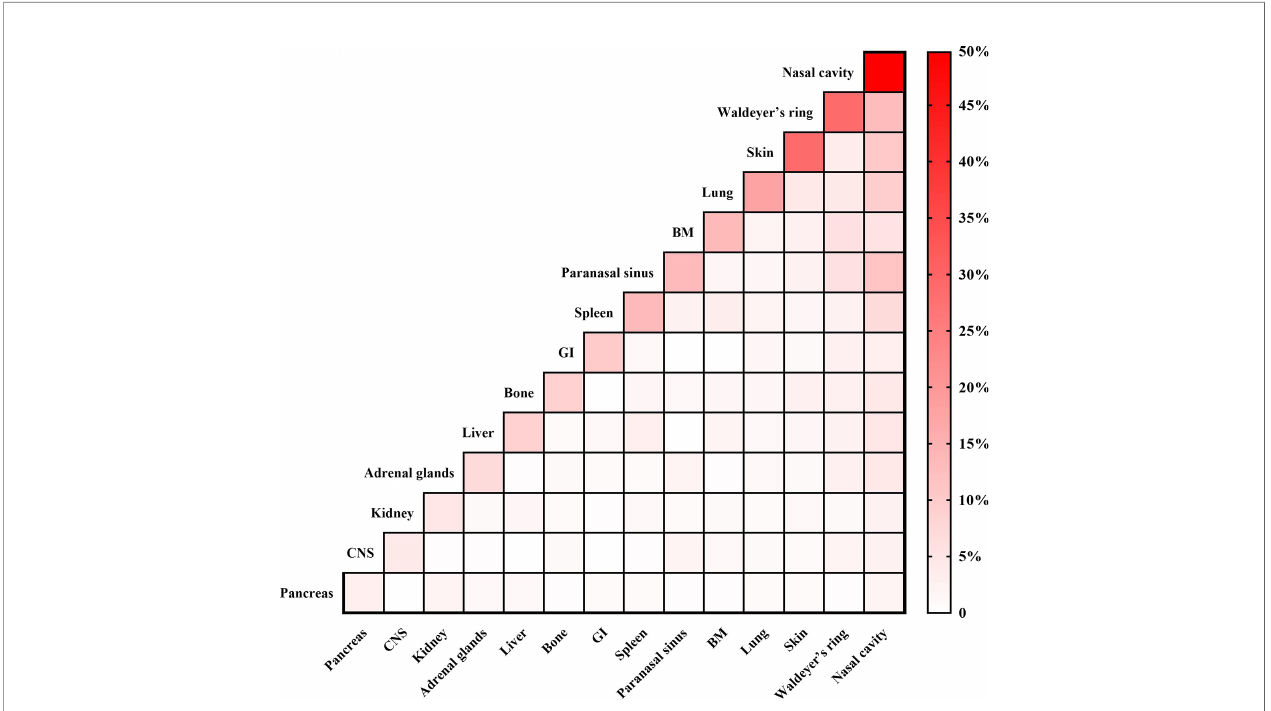
FIGURE 1 | Distribution of extranodal involvement sites in 336 patients with advanced-stage natural killer/T-cell lymphoma. BM, bone marrow; CNS, central nervous system; GI, gastrointestinal tract.